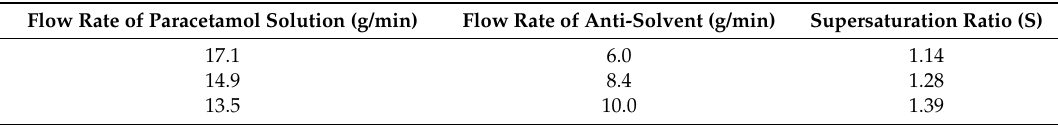
Table 1. Overview of the used flow rates and calculated supersaturation